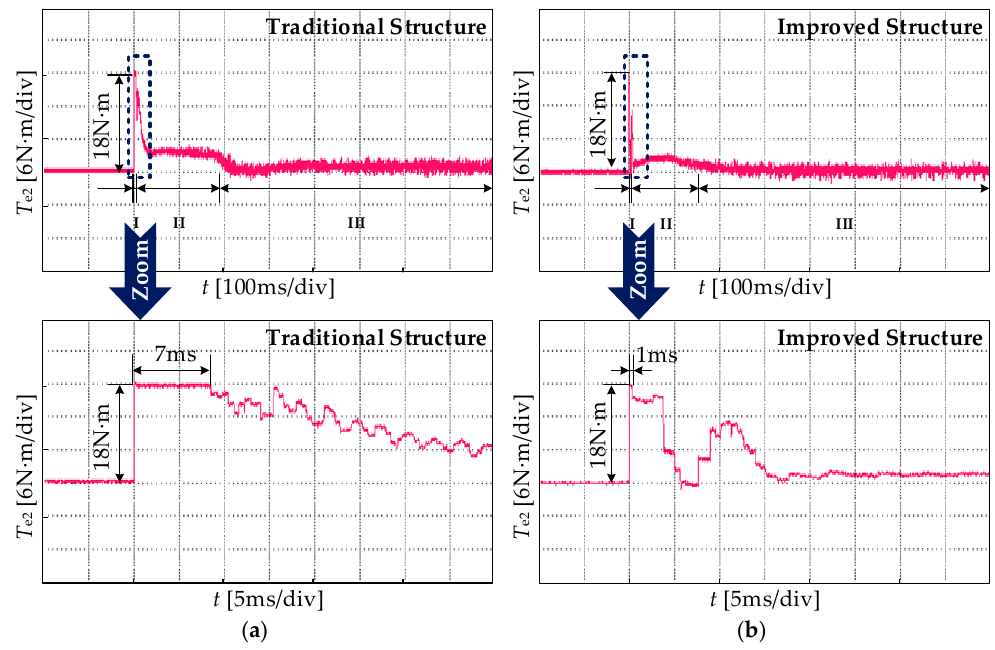
Figure 16. Electromagnetic torque output of the second motor during the start-up of motors with load: ( a ) Electromagnetic torque output in the traditional structure; ( b ) Electromagnetic torque output in the improved structure.